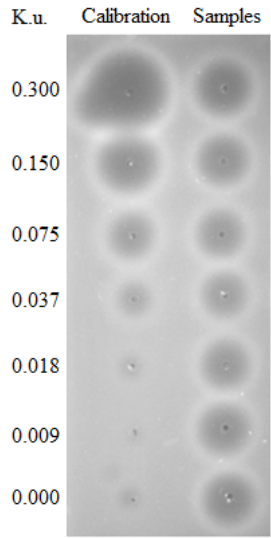
Figure 3. Deoxyribonuclease (DNase) activity measured using the single radial enzyme diffusion (SRED) method in Kunitz units (K.u.). Plasma samples were analyzed using a gel containing DNA after overnight incubation at 37 °C in the dark. The area of the circles represents DNA in the gel cleaved by DNase in the plasma samples. Dilutions of DNase were used as a calibrator. The endeavors to increase the sensitivity of measurement continued, and Nakajima et al.